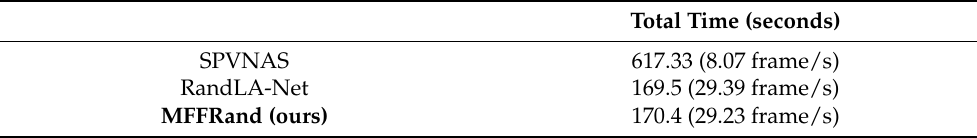
Table 3. The inference time of different approaches (Tested on sequence 19 of the SemanticKITTI